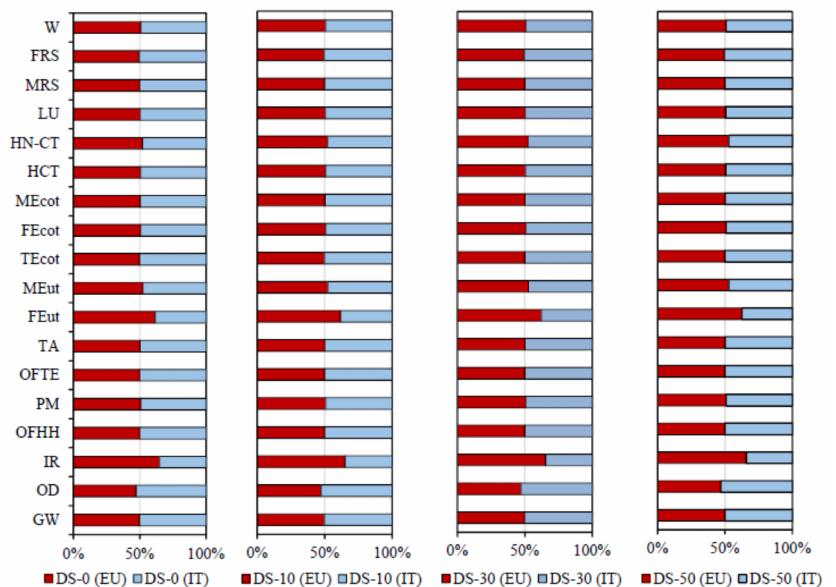
Figure 8. Characterization factors (reported as percentage) for European and Italian energy